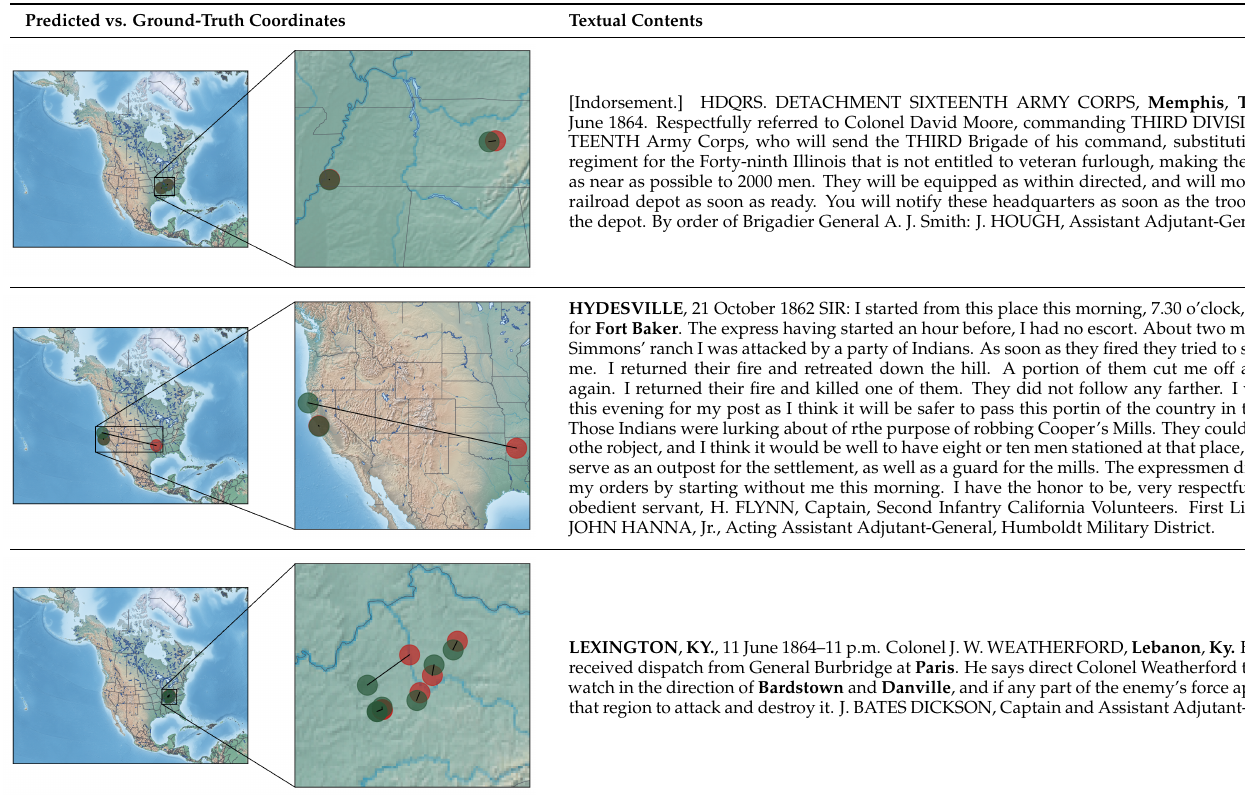
Table 5. Examples from the WOTR corpus, showing predictions vs. ground truth